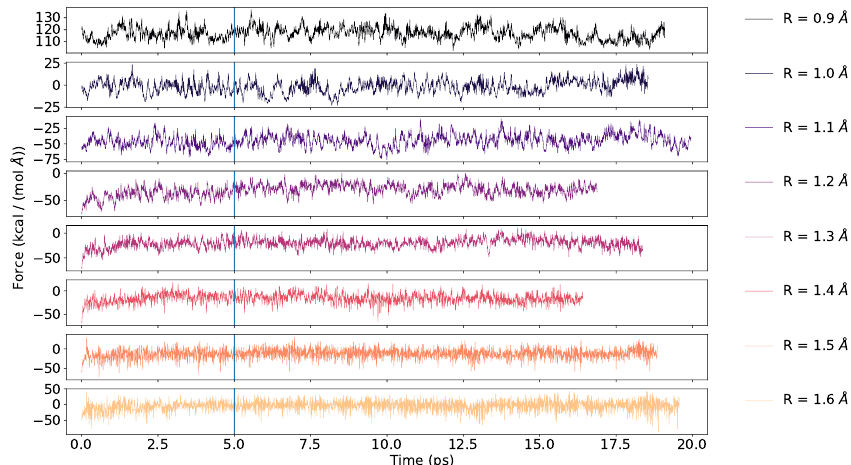
Figure 2. Force ( λ ) acting on the constraint—here for PhOH at a constrained d(A–H). The vertical line at 5.0 ps marks the equilibration time in relation to the production run.